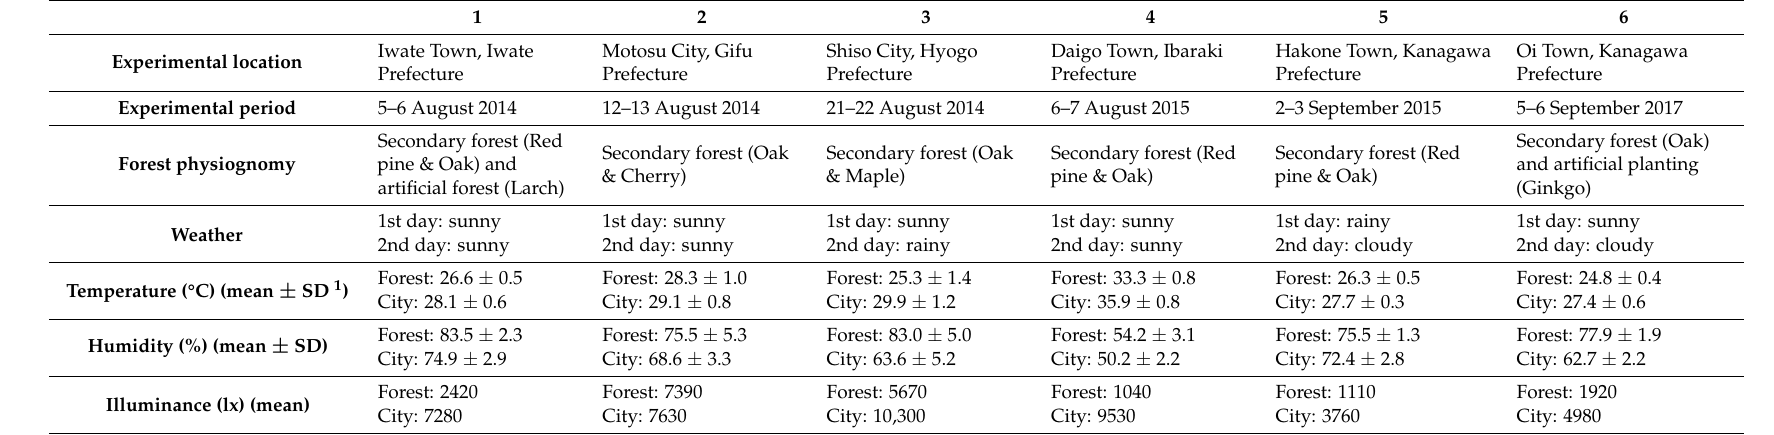
Table 2. The details regarding the experiment sites in the